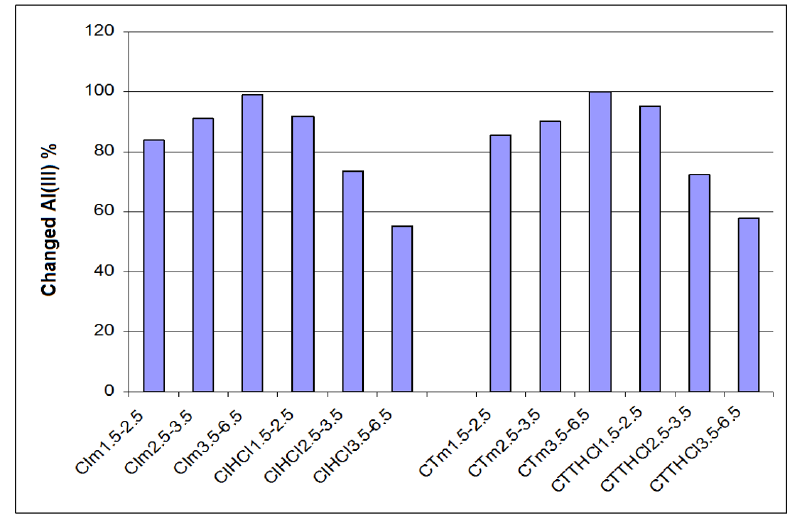
Figure 4. Aluminum percent changed through chemo-sorption in industrial and traditional ceramics treated with HCl and untreated.